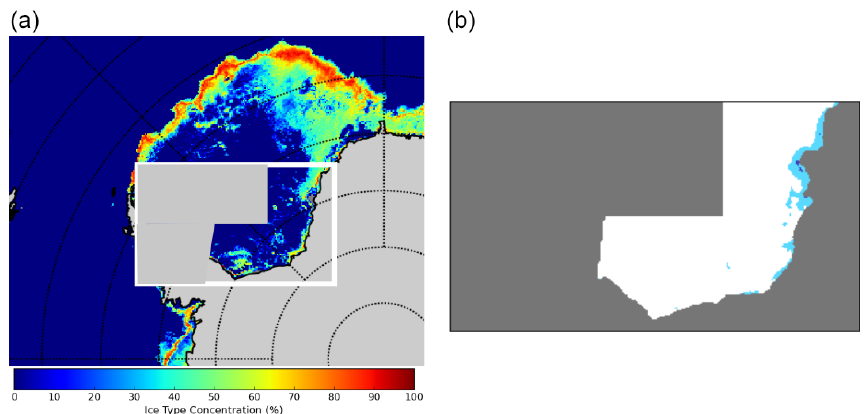
Figure 10. (a) Map of YI, 19 May 2017; (b) PSSM polynya map in the area indicated by the white rectangle in the YI map (dark blue: open water, light blue: thin ice, white: other ice, grey: masked-out area).